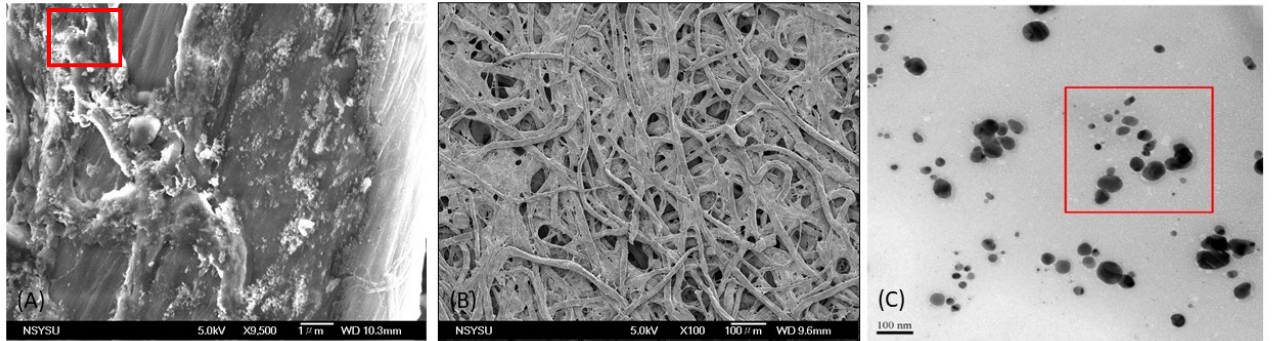
Figure 1. SEM image of paper-based chip: ( A ) silver nanoparticle (AgNP) coating on paper-based chip at 9500×, ( B ) silver nanoparticles (AgNPs) and glycerol observed at 100×, and ( C ) TEM image of silver nanoparticles (AgNPs), where the measured particle size averaged around 43 nm.